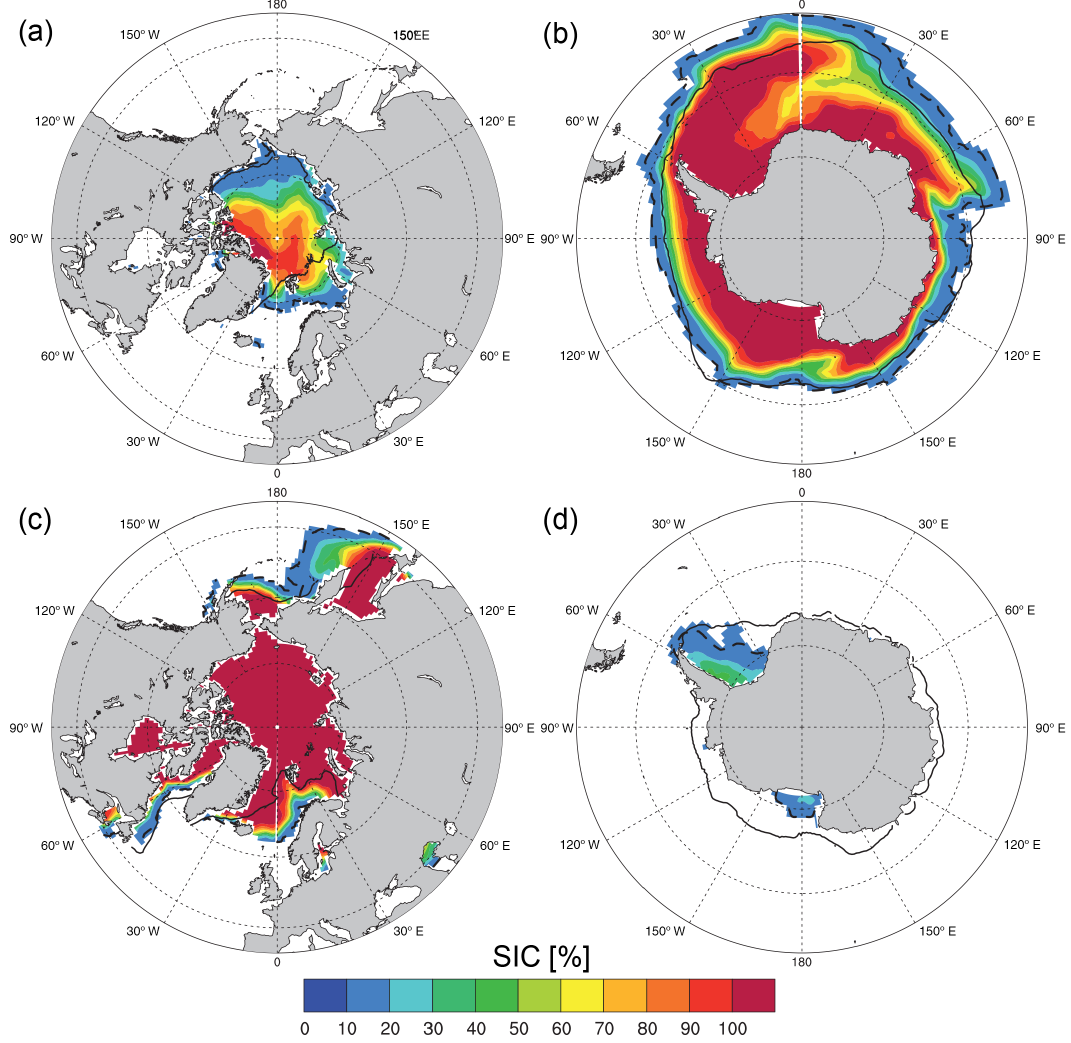
Figure 8. Sea-ice cover (SIC) as simulated by CNRM-ESM1 averaged over 1986–2005. Top panels represent composite of September sea-ice cover, while bottom panels are for March. Iso-15% of SIC serves as comparison between model results and NSIDC observations (Cavalieri et al., 1996) averaged over 1986–2005; model results and observations are indicated with dashed and solid black lines,